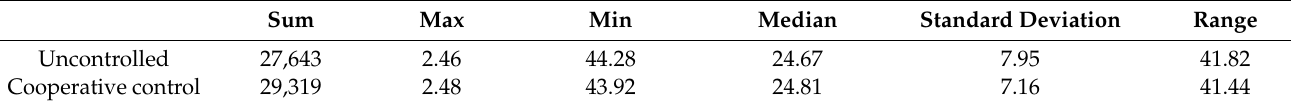
Table 10. Turnover results.